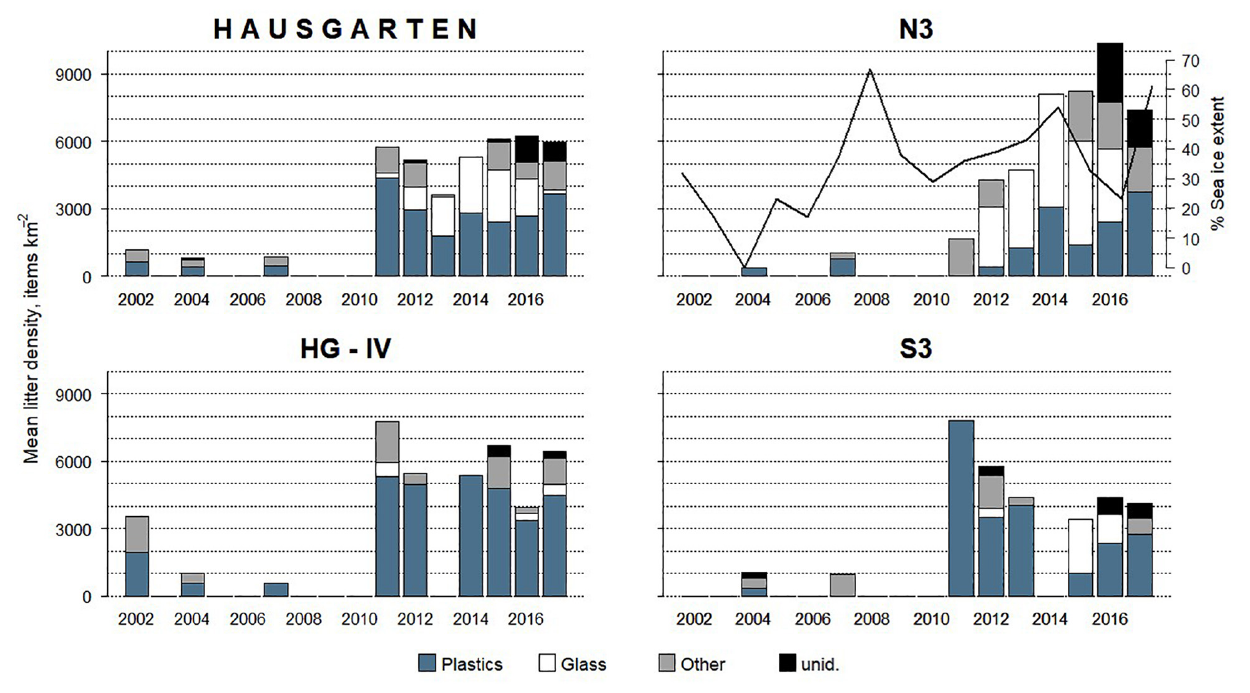
FIGURE 2 | Mean annual litter density and composition at HAUSGARTEN (all stations combined) and individual stations between 2002 and 2017. The percentage of summer sea ice extent is shown only at N3 highlighting the inverse trend during the last 3 years of the time series.